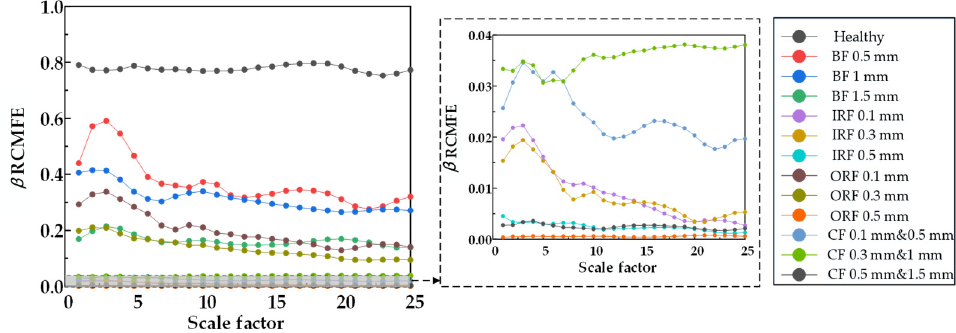
Figure 27. β RCMFE entropy values of 25 scale factors under different damage degrees.